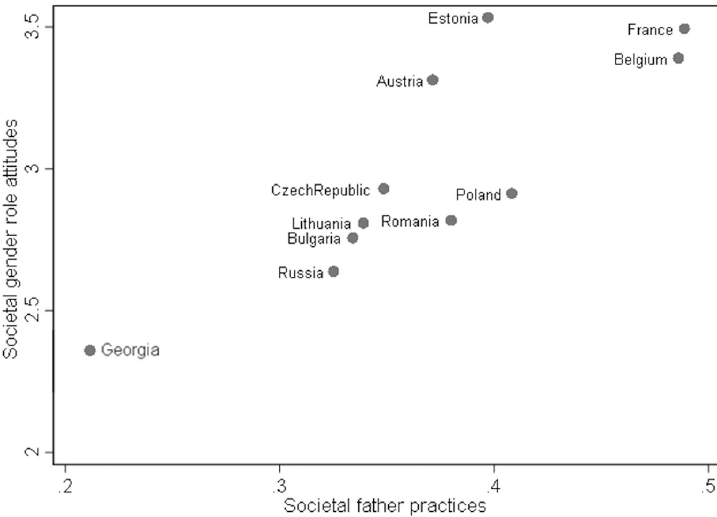
Fig 1. Distribution of societal gender ideologies and societal father practices, by